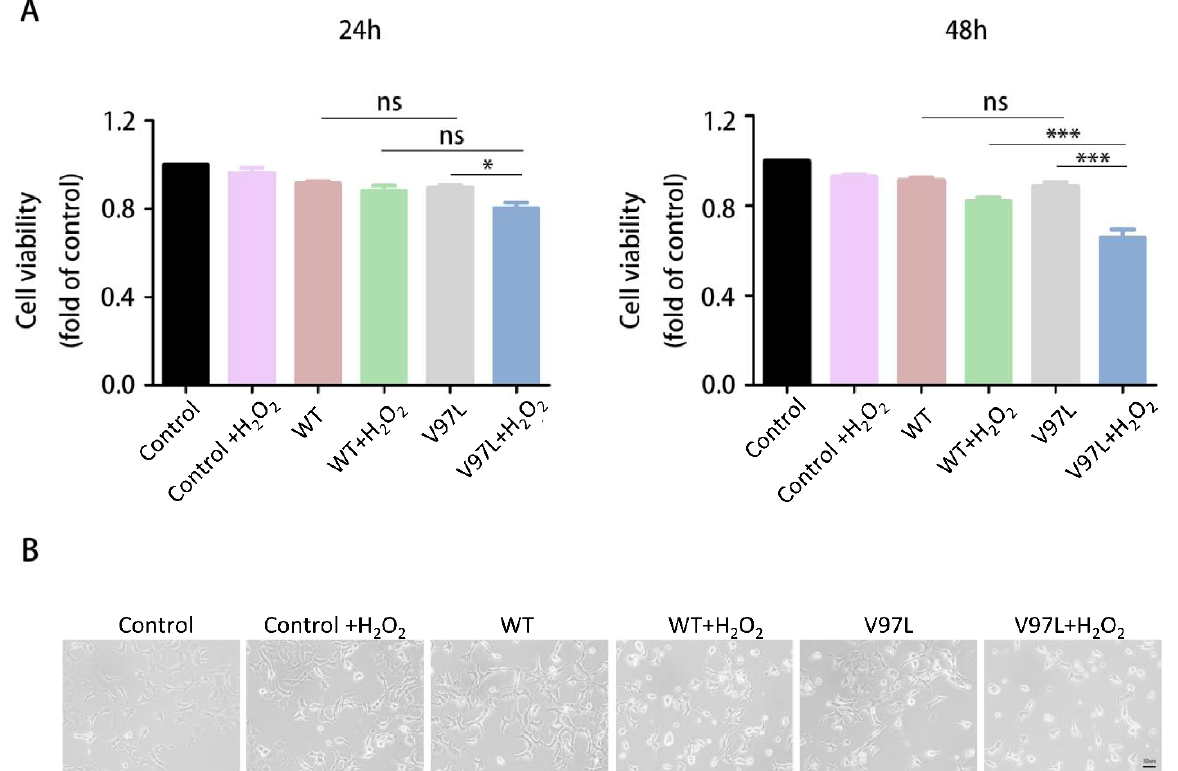
Figure 3. Effect of HSPB1-p.V97L mutation on H 2 O 2 -treated SH-SY5Y cells. ( A ) Effect of HSPB1-p.V97L mutation on cell survival using CCK-8 cell viability assay. SH-SY5Y cells were transiently transfected with plasmid vector expressing p.V97L mutant HSPB1 or wild-type HSPB1 for 24 h or 48 h and then incubated with H 2 O 2 (300 μM) for 24 h ; ( B ) cell morphology was observed with an inverted phase-contrast microscope. Control = SH-SY5Y cells. Data are presented as the means ± SEM from three independent experiments performed in triplicate. ns, no significance; * p < 0.05; *** p < 0.001. Scale bar = 50 µm.